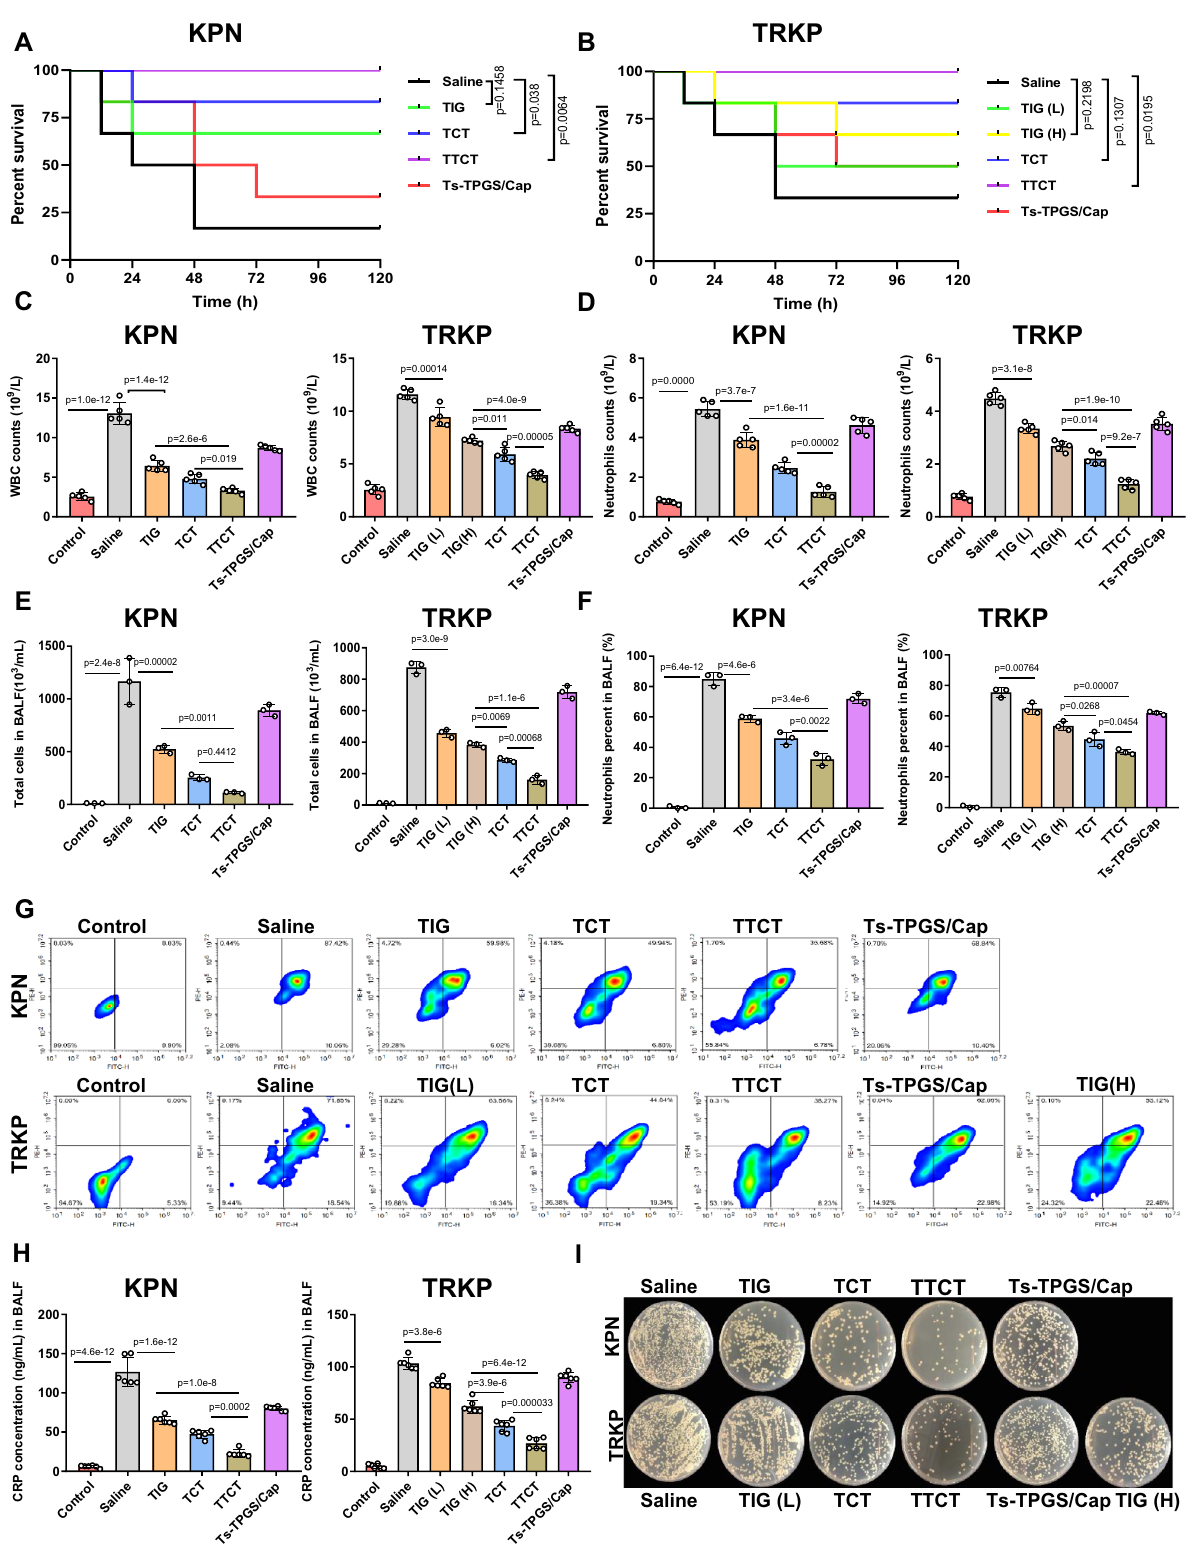
Then, we investigated the levels of total cells, neutrophil percentages, and C reactive protein (CRP) in BALF to further evaluate the anti-infective ef fi cacy of TTCT in vivo. As shown in Fig. 7E, the total cells in BALF excessively increased in KPN- and TRKP-infected mice. When the infected mice received TIG- containing preparations and Ts-TPGS/Cap nanorods, the